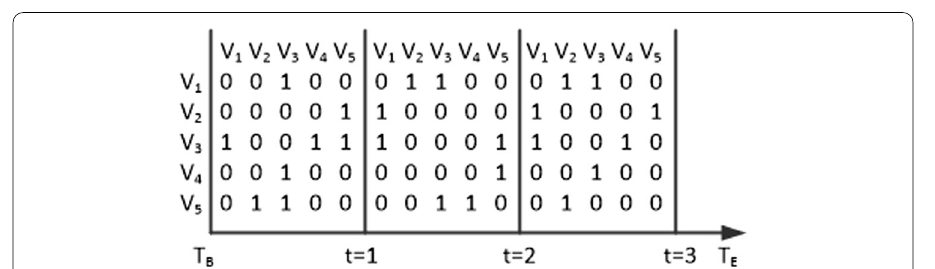
Fig. 2 Representation of the adjacency matrix in the case of equal length of time